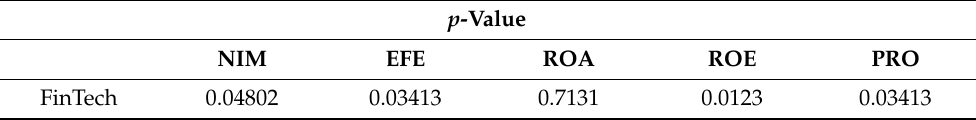
Table 10. Spearman’s rank correlation p